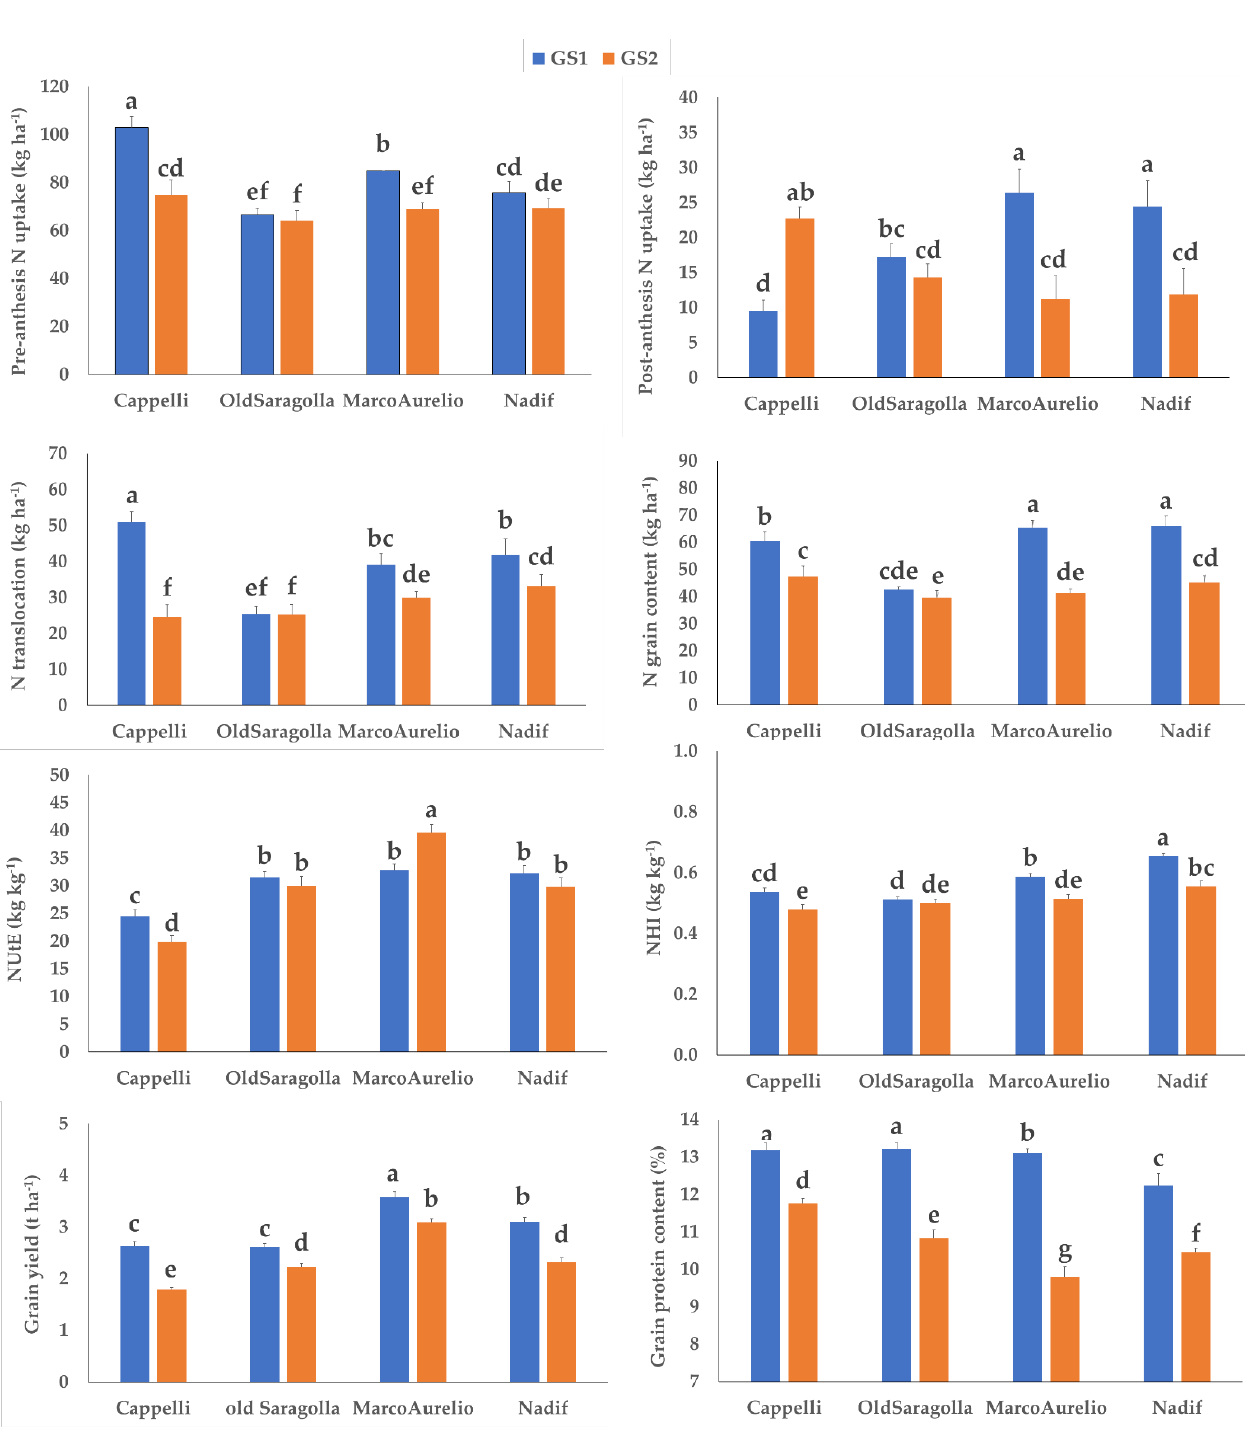
Figure 1. Effect of the interaction growing season × variety on pre-anthesis N uptake (kg ha − 1 ), post-anthesis N uptake (kg ha − 1 ), N translocation (kg ha − 1 ), nitrogen utilization efficiency (NUtE; kg kg − 1 ), nitrogen harvest index (NHI; kg kg − 1 ), N grain content (kg ha − 1 ), grain yield (t ha − 1 ) and grain protein concentration (%). GS1, 2017–2018 growing season; GS2, 2018–2019 growing season. Letters indicate significant differences at p ≤ 0.05 according to Tukey’s test. Vertical bars indicate standard errors (n = 24).